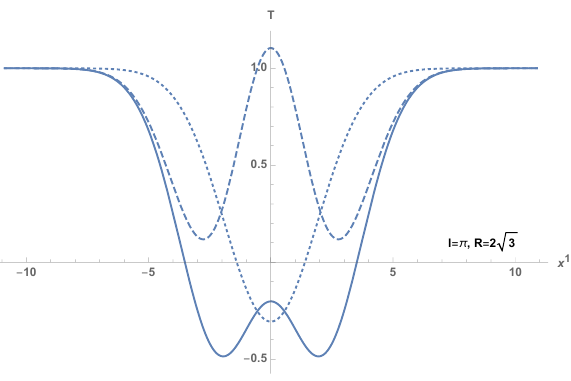
Figure 21 . Tachyon lump pro(cid:12)le for a coincident pair of D( p (cid:0) 1)-branes in the toy model, plotted against the pro(cid:12)les for the single D( p (cid:0) 1) derived from excited and unexcited twist (cid:12)elds at R = 2 Excited twist (cid:12)elds are not needed when the pair of D( p (cid:0) 1)-branes are separated.